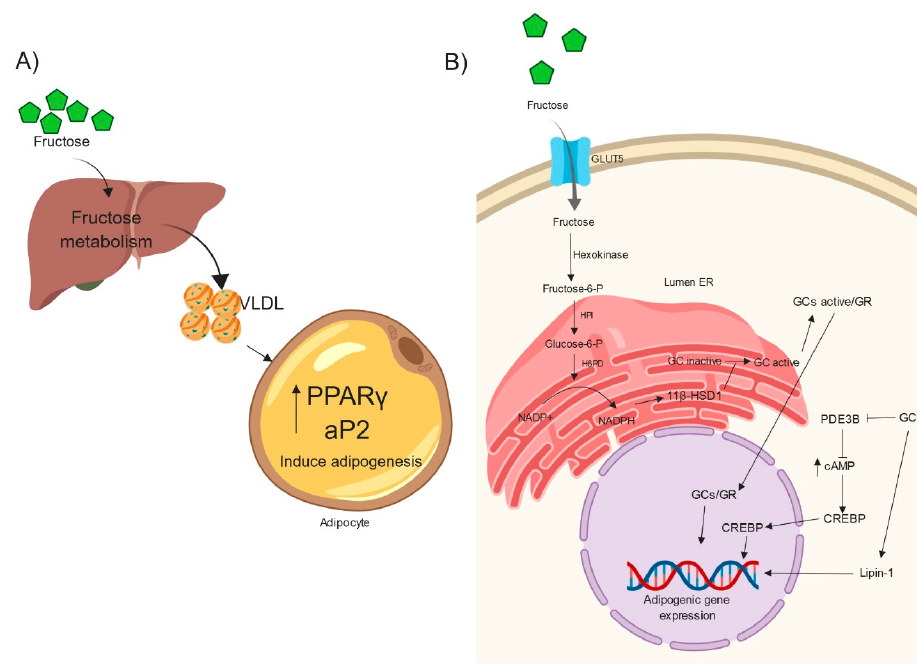
Figure 2. Fructose induces adipogenesis through very-low-density lipoprotein (VLDL) production and glucocorticoid (GC) signalling. ( A ) High fructose intake increases triglycerides and VLDL production, which induce adipogenesis by increasing PPAR γ and aP2 expression. ( B ) Fructose metabolism in adipocytes promotes glucocorticoid activation by inducting 11 β -HSD1. The effects of GCs in adipocyte precursors cells induce the expression of adipogenic genes through a few mechanisms. VLDL: Very-low-density lipoprotein; GCs: Glucocorticoids; GR: Glucocorticoid receptor; NADPH: Nicotinamide adenosine dinucleotide phosphate; 11 β -HSD1: 11-beta hydroxysteroid dehydrogenase type 1; CREB: cAMP response element-binding protein; cAMP: Cyclic adenosine monophosphate; PDE3BB: Cyclic-nucleotide phosphodiesterase 3B; HPI: Hexose-phosphate isomerase; H6PD: Hexose-6-phosphate dehydrogenase. Created with Biorender.com.